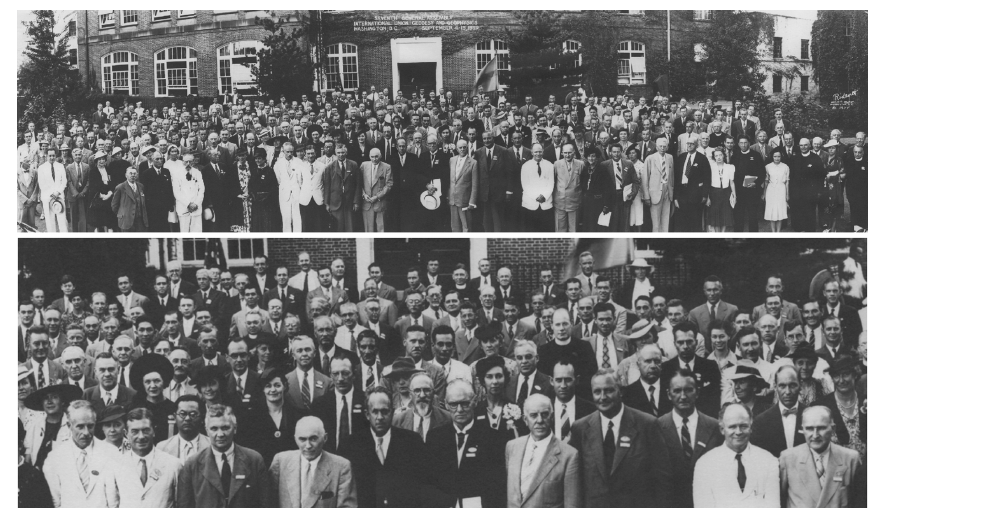
Figure 8. Participants of the VII General Assembly (upper panel); details of the central part of the photo (lower panel) (source: IUGG